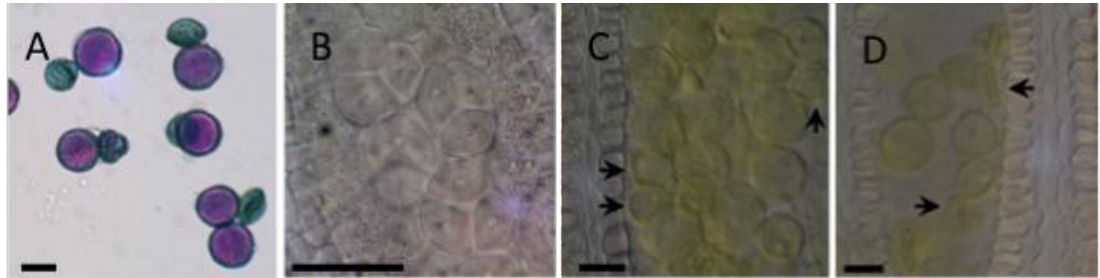
Figure 1. Developmental arrest in pirl1 , pirl9 pollen. ( A ) Alexander-stained dehisced pollen from a pirl1/PIRL1 , pirl9 plant, segregating at 50% for the pirl1 , pirl9 mutant phenotype. Purple stain indicates viable pollen; ( B ) Nomarski DIC microscopy of post-meiotic tetrads in a pirl1/PIRL1 , pirl9 anther in which double mutant microspores are segregating but cannot be clearly identified; ( C ) A pirl1/PIRL1 , pirl9 anther with mitotic stage pollen; arrows indicate developmentally arrested pollen; ( D ) A mature pirl1/PIRL1 , pirl9 anther; arrows indicate shrunken inviable double mutants segregating within the pollen population. Scale bars = 20 µm